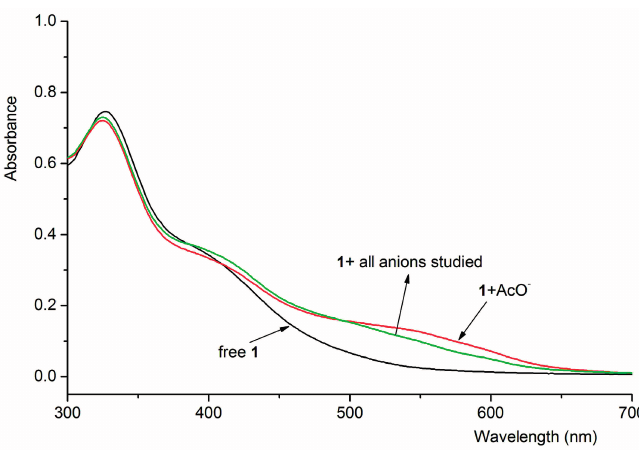
Figure 3. UV-Vis spectral changes of compound 1 (4.0 × 10 − 5 mol·L − 1 ) upon the addition